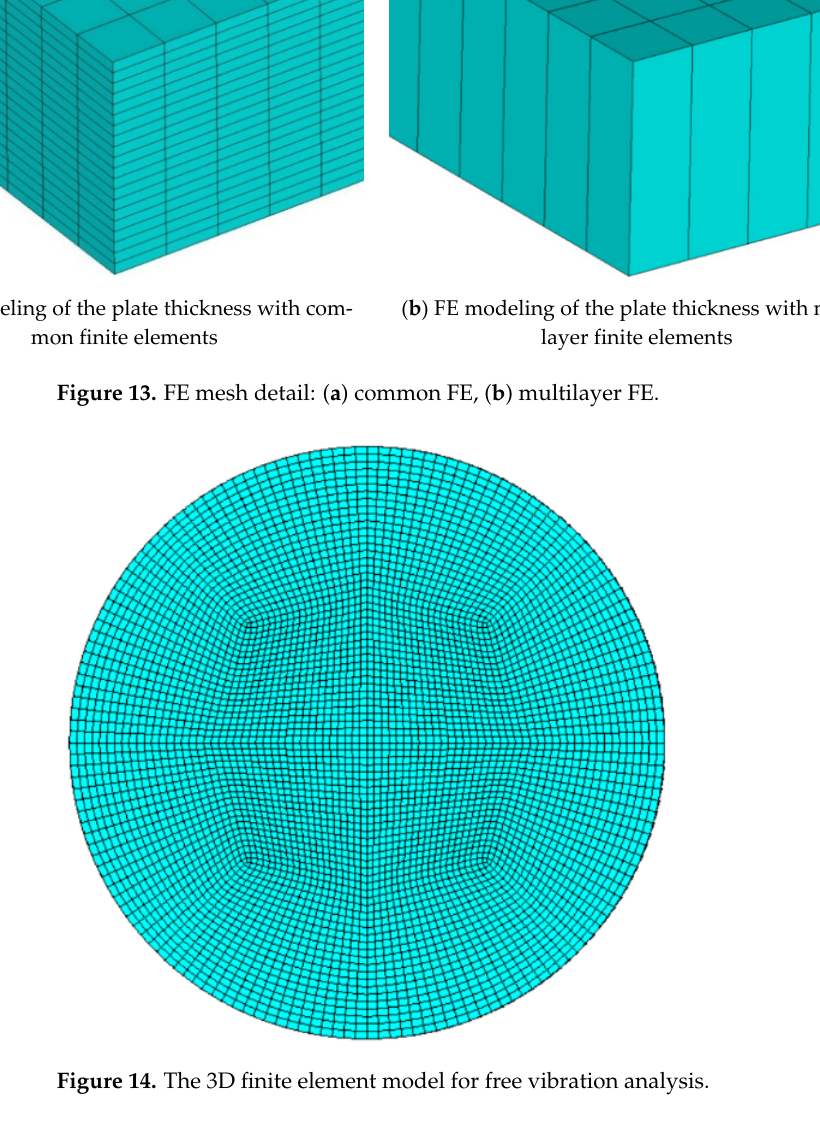
Figure 14. The 3D finite element model for free vibration analysis.